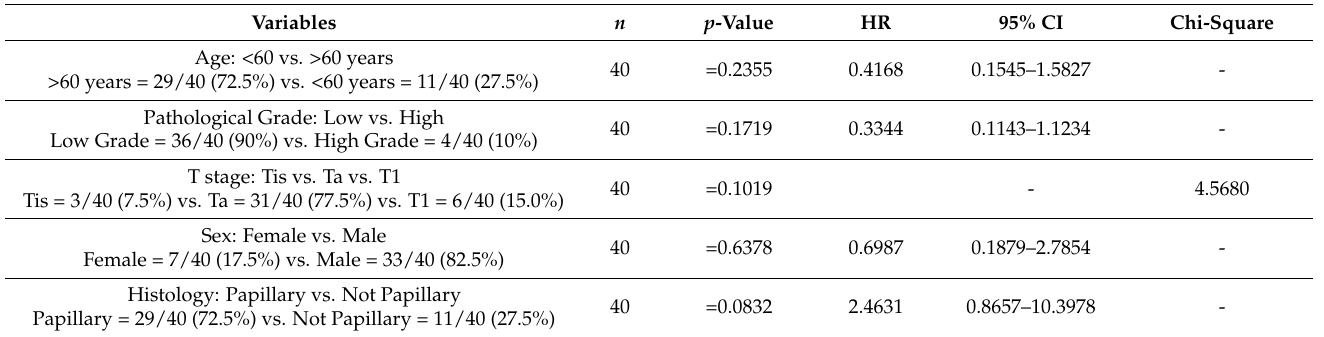
test for PD ‐ L1 , TWIST1 , ZEB1 and VIM. TIMP2 was analyzed by Welch’s test. * p < 0.001, # p < 0.05.